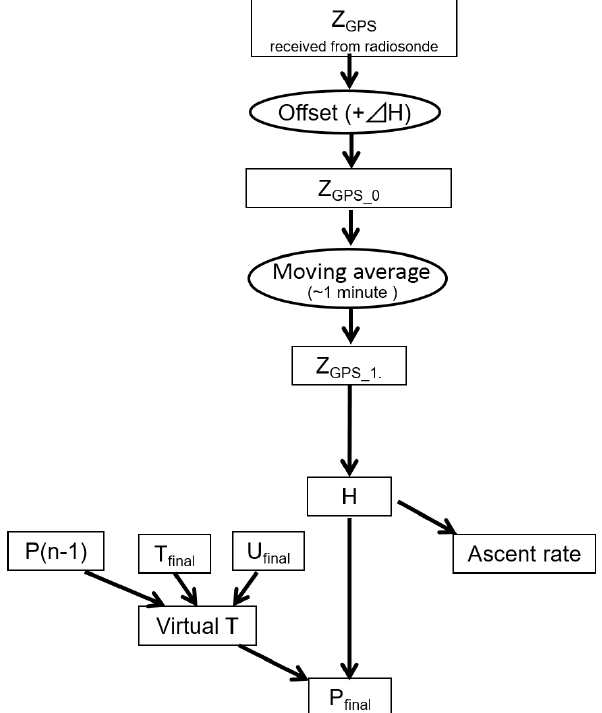
Figure 4. GRUAN data processing flow for RS-11G geopotential height and pressure measurement (Kizu et al., 2018). Z GPS is the GPS geometric altitude, (cid:49)H is the offset between balloon release altitude and GPS geometric altitude upon balloon release, H is the geopotential height, T final and U final are the corrected final temper- ature and RH, respectively, and P final is the corrected final pressure. Rectangles and ellipses indicate input or output data and correction processes,